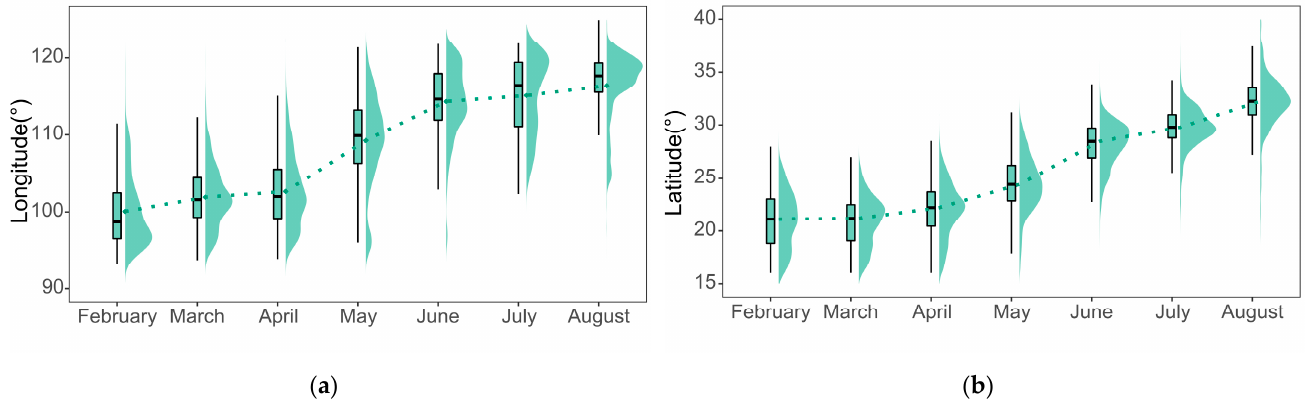
Figure 6. Spatial distribution and probability density of the FAW at ( a ) longitude and ( b ) latitude. The dotted line connecting point is the median of the longitude or latitude of the landing points for each month.